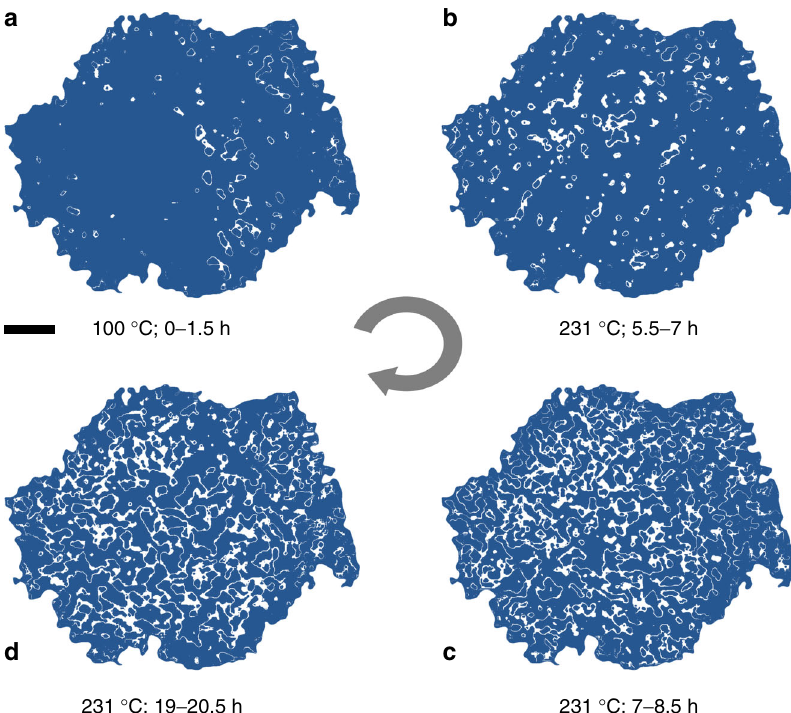
Fig. 2 The development of the Ni reduction reaction front upon heating. The white pixels in the map are the pixels that have Ni K-edge position at 8341 ± 0.1 eV. The blue area in the fi gure is associated with local Ni K-edge position outside of the de fi ned Ni K-edge energy window. a is the reaction front map over the particle after it is heated for up to 1.5 hours at 100 °C. b - d are the reaction front maps over the particle after it is heated at 231 °C for up to 7, 8.5, and 20.5 hours, respectively.The scale bar is 2 μ m